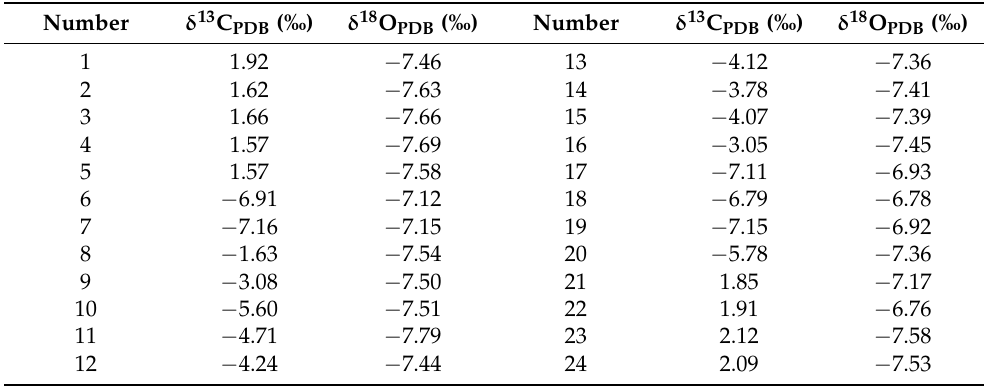
Table 1. Stable isotope data of vein filling saddle dolomite from P é